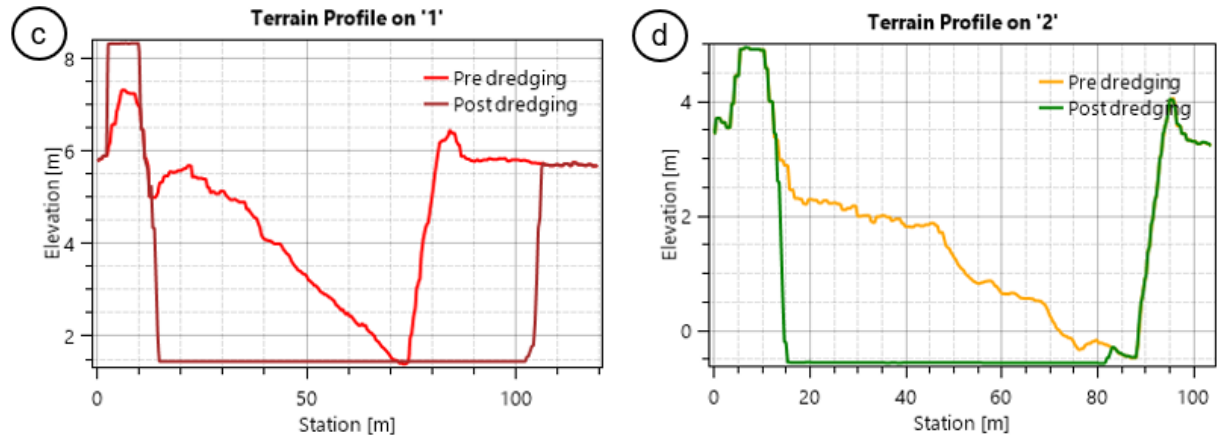
Figure A1. Terrain pre-dredging ( a ), terrain post-dredging ( b ), and profile 1 ( c ) and 2 ( d ) for comparison of both terrains.